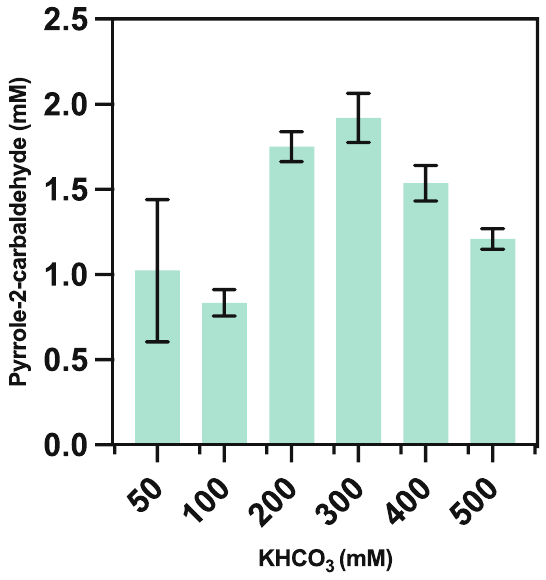
Figure 3. Comparative pyrrole-2-carbaldehyde yield, obtained from coupling purified PA0254 and CARse enzymes in the presence of 500 mM KHCO 3 , as analysed via HPLC from replacement of 20 mM NADPH with wildtype bsGDH or commercially available CODEXIS CDX901-GDH at 0.30 mg/mL in the presence of 50 mM glucose. Reactions were incubated at 30 °C for 18 h. No observable carboxylation occurred in the no-biocatalyst controls (NBC).